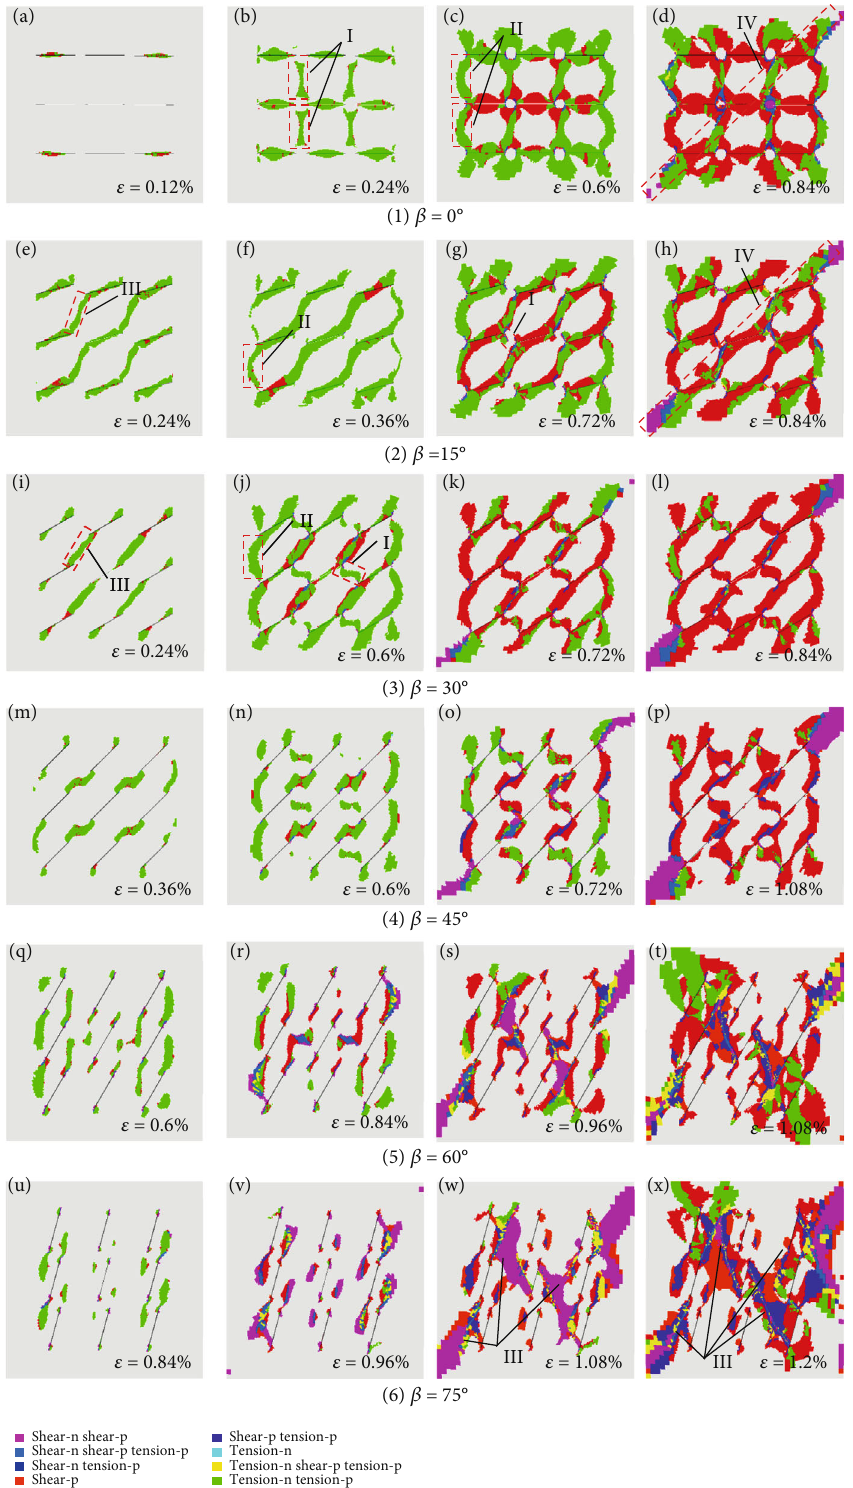
Figure 9: Failure of jointed rock